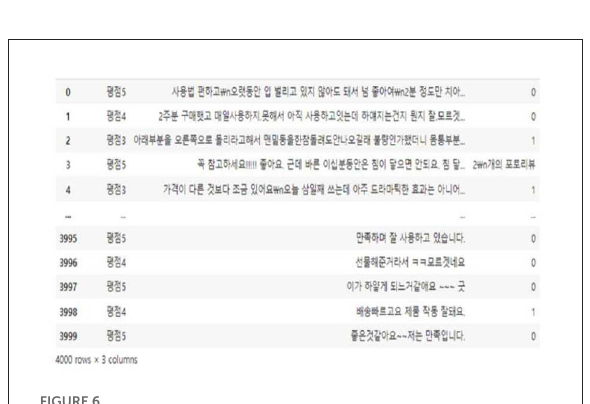
FIGURE6 Comment dataset collected with